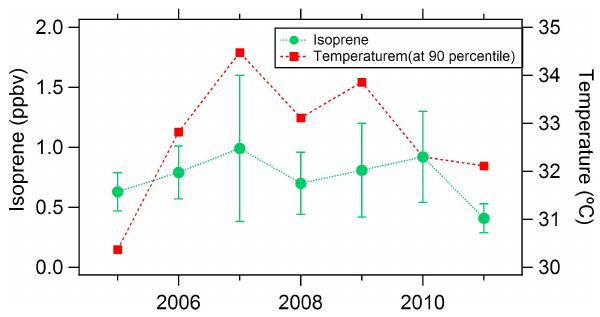
Figure 10. Variations in the daytime averages of isoprene concen- trations (green dots) and 90th percentile temperature (red squares) in Beijing, August between 2005 and